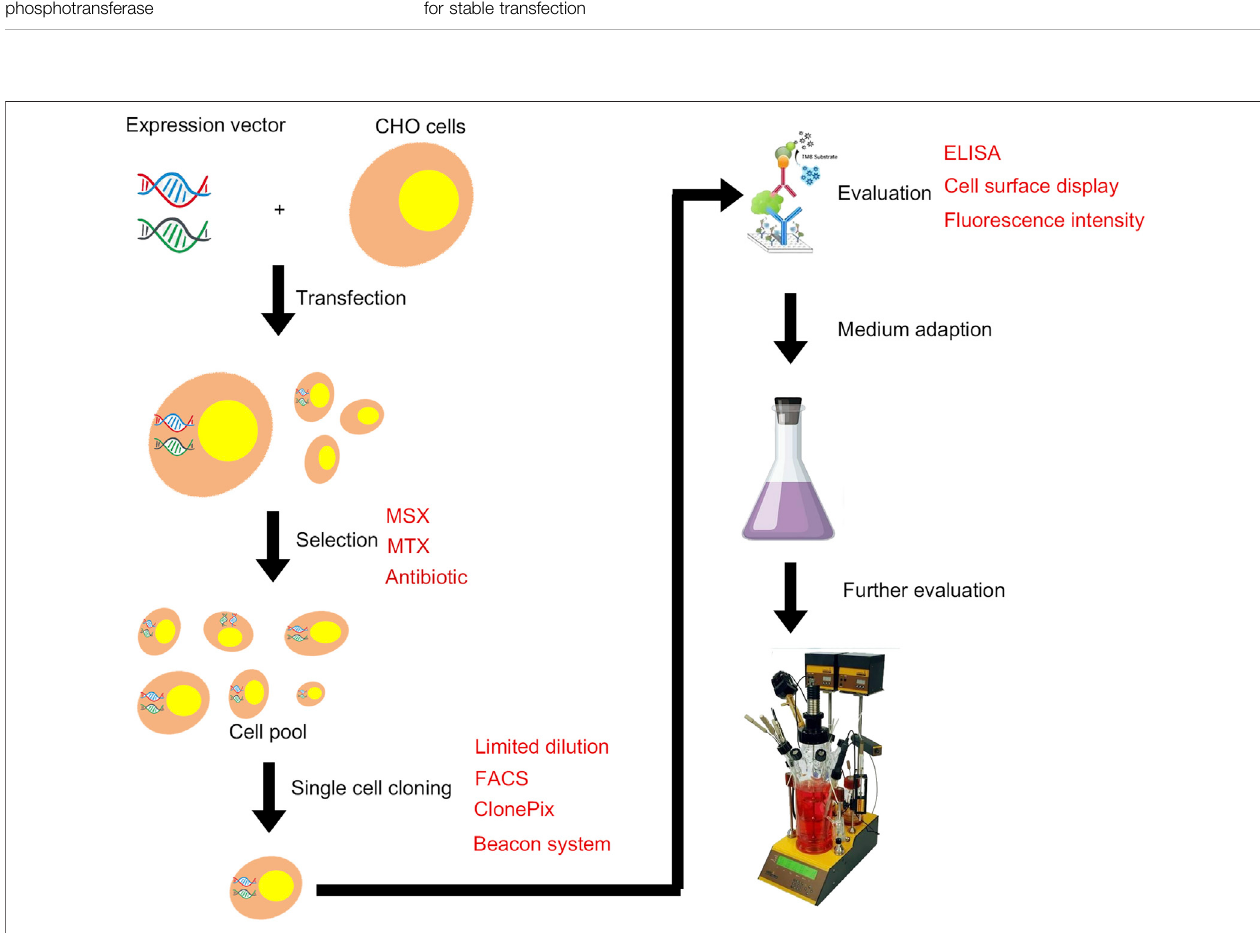
FIGURE 1 | Illustration of the typical development of a mammalian cell line for recombinant protein manufacturing.